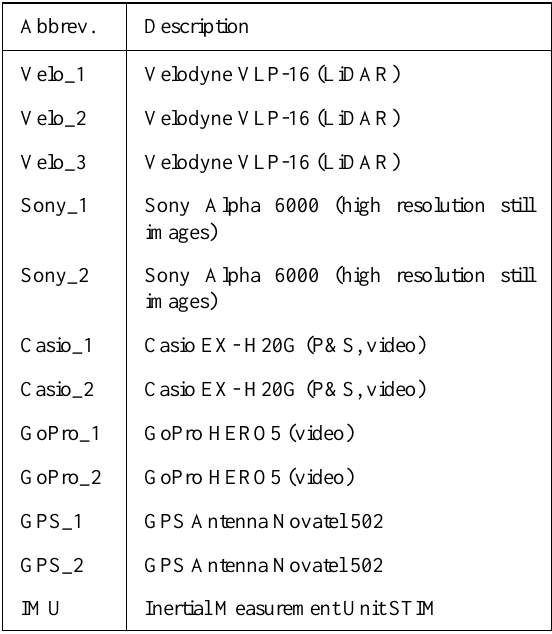
Table 1. Components of the mapping